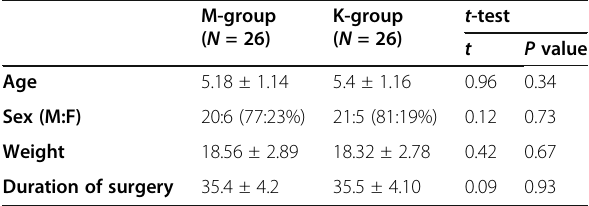
Table 1 Demographic and clinical